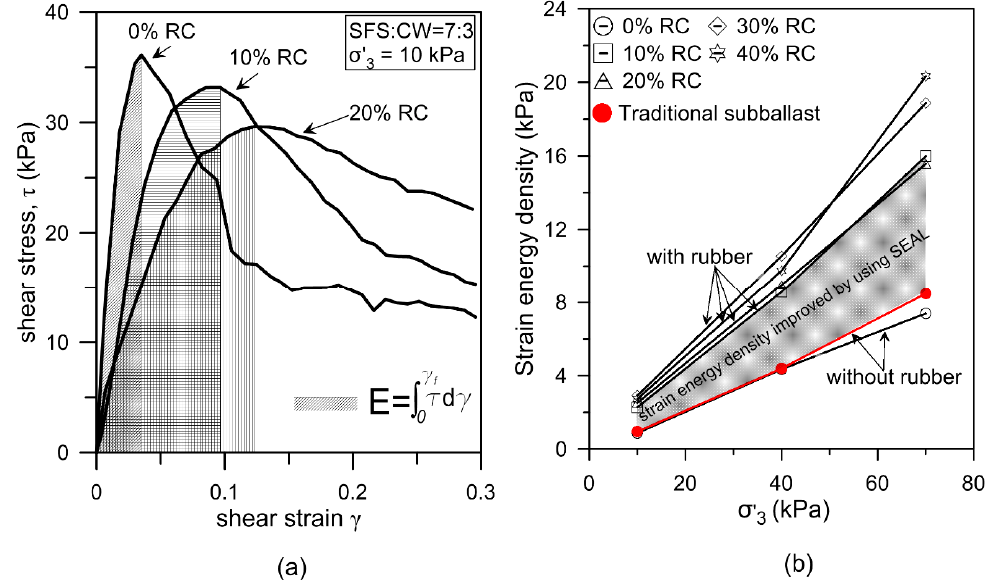
Figure 3. ( a ) Definition of Strain energy density; ( b ) Stain energy density of SFS+CW+RC mixtures (modified after Qi et al.